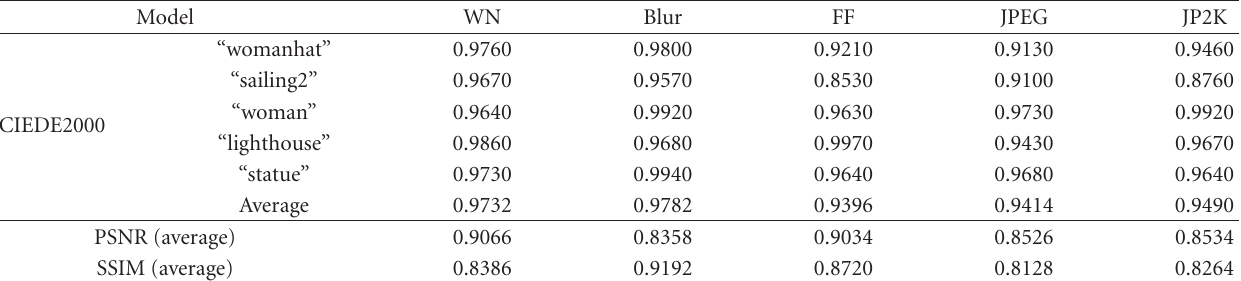
Figure 2: The five reference images. Table 2: CC between algorithm and